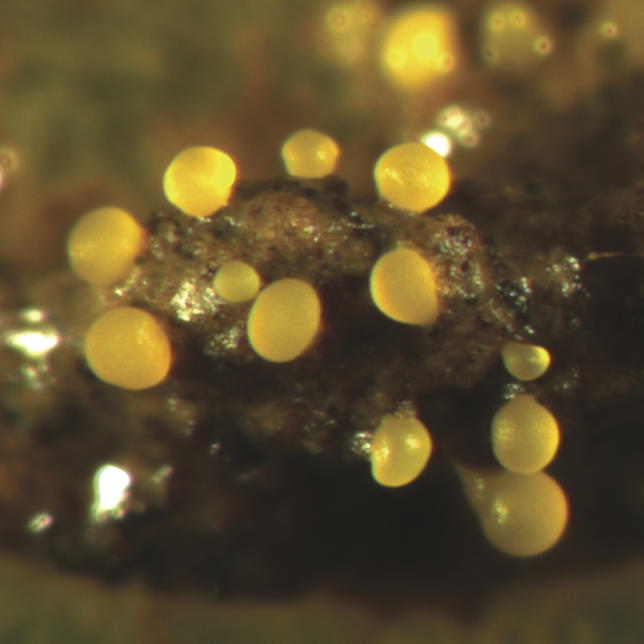
Some 100,000 Myxococcus xanthus cells amassed into a fruiting body with spores, above. Experimental competitions showed that some strains of this social bacterium exploited others. (Image: Michiel Vos)